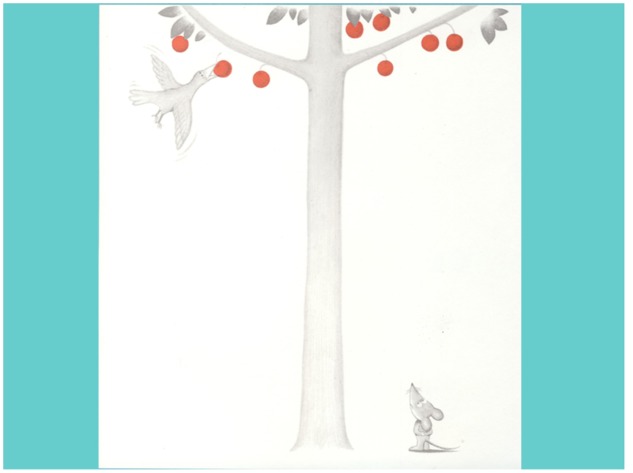
Sample page from the wordless picture book.